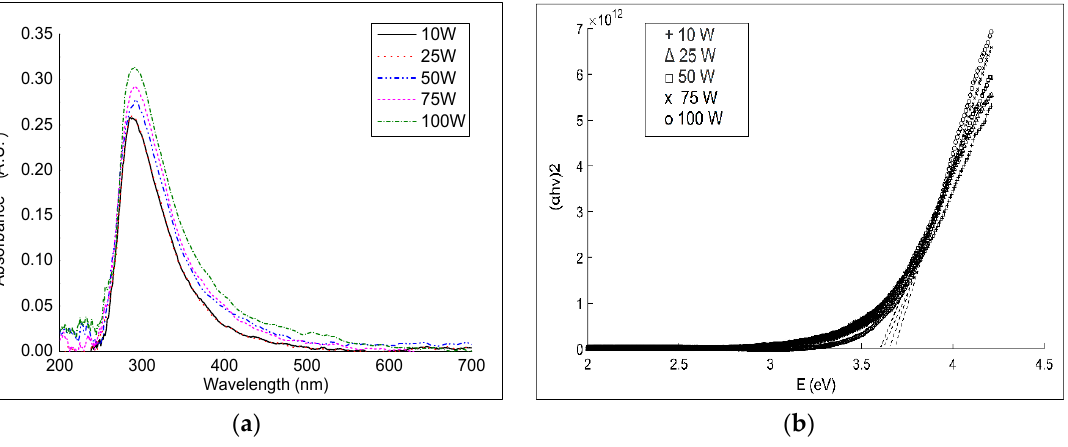
Figure 4. ( a ) UV–vis absorption spectrum of geranium oil-derived films; ( b ) The optical energy gap of geranium oil-derived films fabricated at various radio frequency (RF) powers.